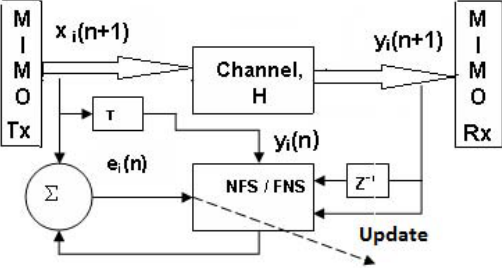
Figure 1. Fuzzy system based channel